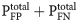
Consensus-based clustering applied to simultaneous intracellular/tetrode recordings.a. Band-passed filtered extracellular voltage signal (black) obtained from a tetrode recording in rat hippocampal CA1. One cell in the vicinity of the tetrode was simultaneously recorded intracellularly (red, [9]). b. Dendrogram (top) obtained by hierarchical clustering with the Single-Link method over the distance matrix (bottom) defined from the pairwise probability of spike misclassification between core clusters. Each leaf of the tree corresponds to a core cluster while the height of each node represents the probability of spike misclassification between the closest core clusters of the linked groups. The final clusters were identified by cutting the cluster tree at 1 –Pth, with Pth = 0.15. c. Dendrogram and distance matrix measured between the final clusters, after consensus clustering. d. Whitened spatiotemporal waveforms of 7 of the final clusters identified by consensus-based clustering. The cluster templates, defined as the average waveforms, are shown in black. Cluster #3 was identified as the single unit matching the intracellularly recorded cell. Spike trains corresponding to cluster #22, #23 and #24 were merged and considered to be the same unit because their cross-correlograms were typical of a bursting cell. The estimated probability of misclassified spikes (PFPtotal+PFNtotal, see Methods) is shown below each final cluster. After comparing the spike train of cluster #3 to the ground truth spikes, we found a true rate of misclassification of FPrate + FNrate = 1.7%.